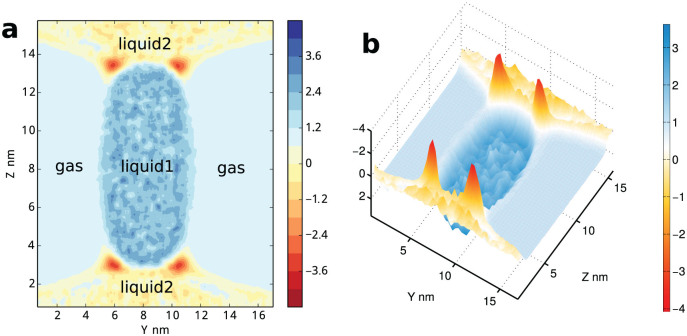
Spatial distribution of Pyy(r) + Pzz(r) − Pxx(r) in gas/liquid1/liquid2 model.It corresponds to line tension but containing bulk pressure as background. The anisotropy of stress is rescaled with the average stress pyy + pzz − pxx ≈ 5.1 bar as unit.